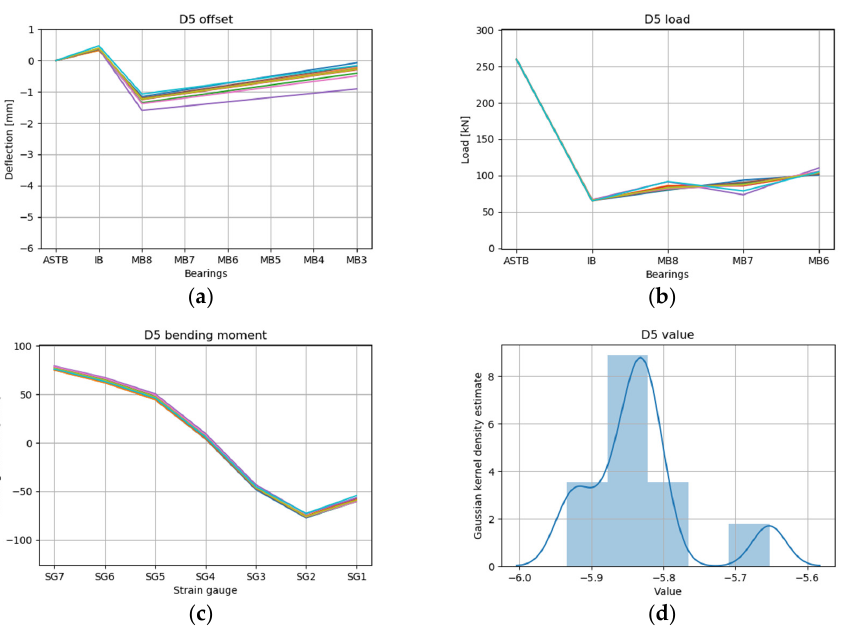
Figure 21. RL results for draft condition D5 top 10 cases: ( a ) offset, ( b ) load, ( c ) bending moment, and ( d ) value. A small difference was observed compared to the difference in the shaft deformation of D5 with the APT full (Figure 21a; IB: 0.5 to 0.4 mm; MB8: −1.1 to −1.6 mm; MB3: −0.1 to −0.9 mm) was increased compared to the shaft deformation of D4 with the APT empty (Figure 20a; IB: 0.4 to 0.3 mm; MB8: −1.4 to −2.3 mm; MB3: −0.4 to −1.9 mm).